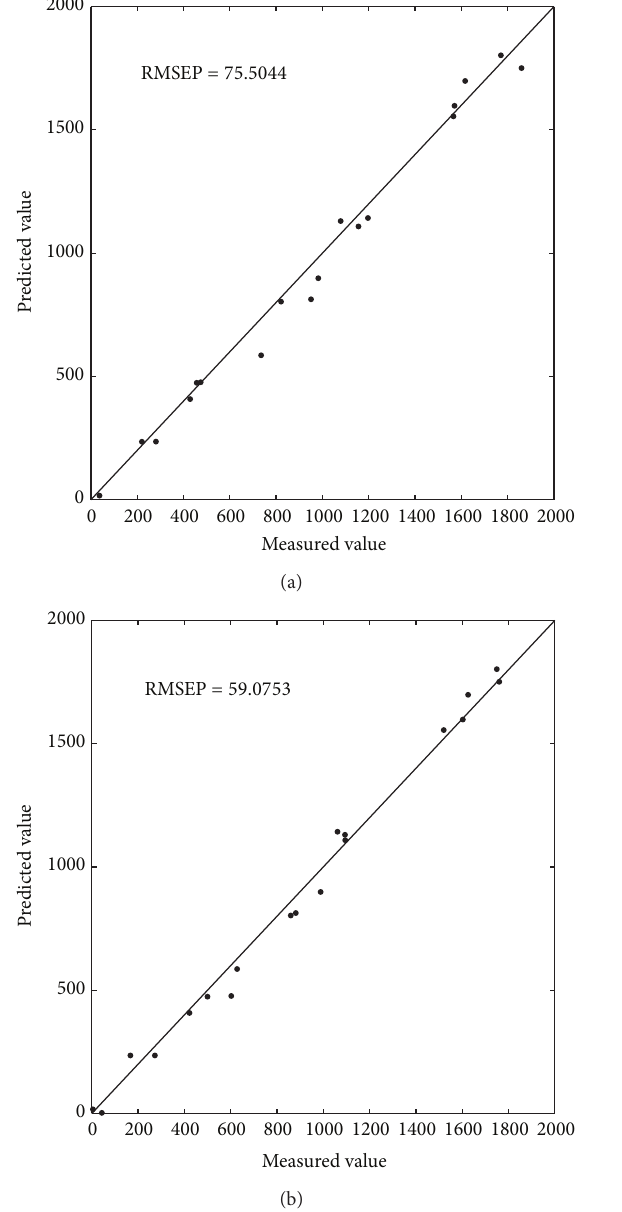
Figure 3: Prediction value versus measured value scatter diagram of different methods for CO. (a) PLS; (b) RBFEI-PLS.